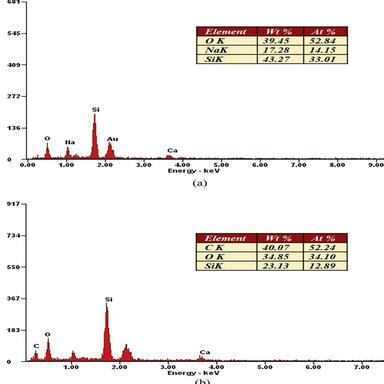
EDS results of (a) pore-expanded silica microsphere with sodium silicate and (b) final autolytic mineral microsphere.